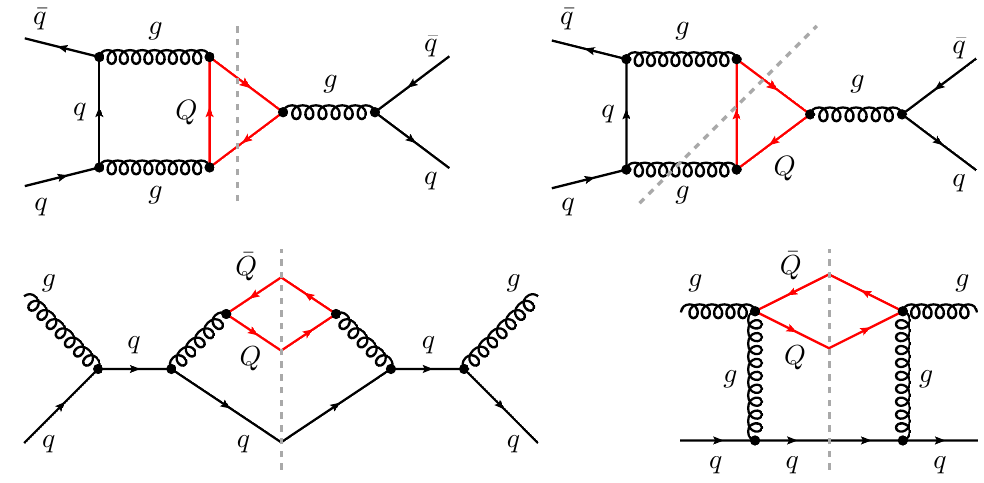
Figure 13 . Representative Feynman diagrams that contribute to the asymmetric production cross section of heavy-quark pairs at O ( (cid:11) 3 ). Upper row: the two-particle cut (right) describes the s interference of the one-loop box diagram with the tree-level graph, while the three-particle cut (left) corresponds to the interference of (cid:12)nal-state with initial-state gluon corrections. Lower row: three- particle cuts that represent a production of heavy quarks via (cid:13)avour